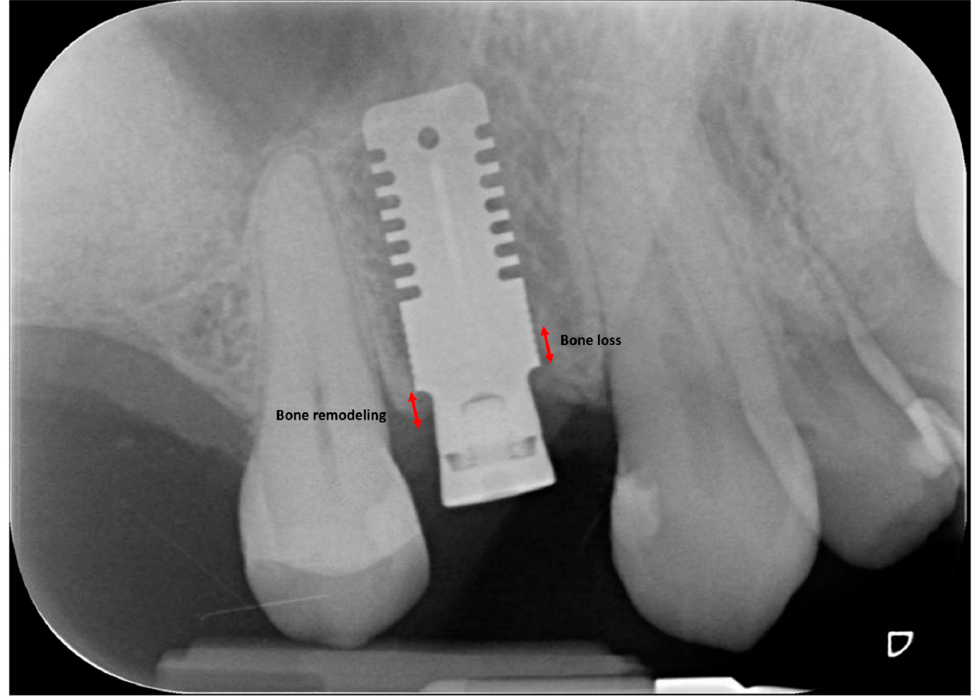
Figure 3. Peri-implant bone resorption is defined as bone loss when occurring apically to the implant shoulder, whereas it is defined bone remodeling when occurring coronally to the implant shoulder. Radiographs showing evident deformation, poor image quality or other problems were immediately repeated. All radiographic measurements were made by a blinded calibrated examiner (A.R.), using a 30-inch led-backlit color diagnostic display and measuring software (Image J, National Institutes of Health, Bethesda, MD, USA). Each measurement was repeated three times at three different time points as proposed by Gomez-Roman and Launer [20]. Examiner calibration was performed by assessing ten radiographs, with a different author (C.S.) serving as a reference examiner. Intra-examiner and inter-examiner concordances were 90.7% and 84.8%, respectively, for linear measurements within ± 0.1 mm.